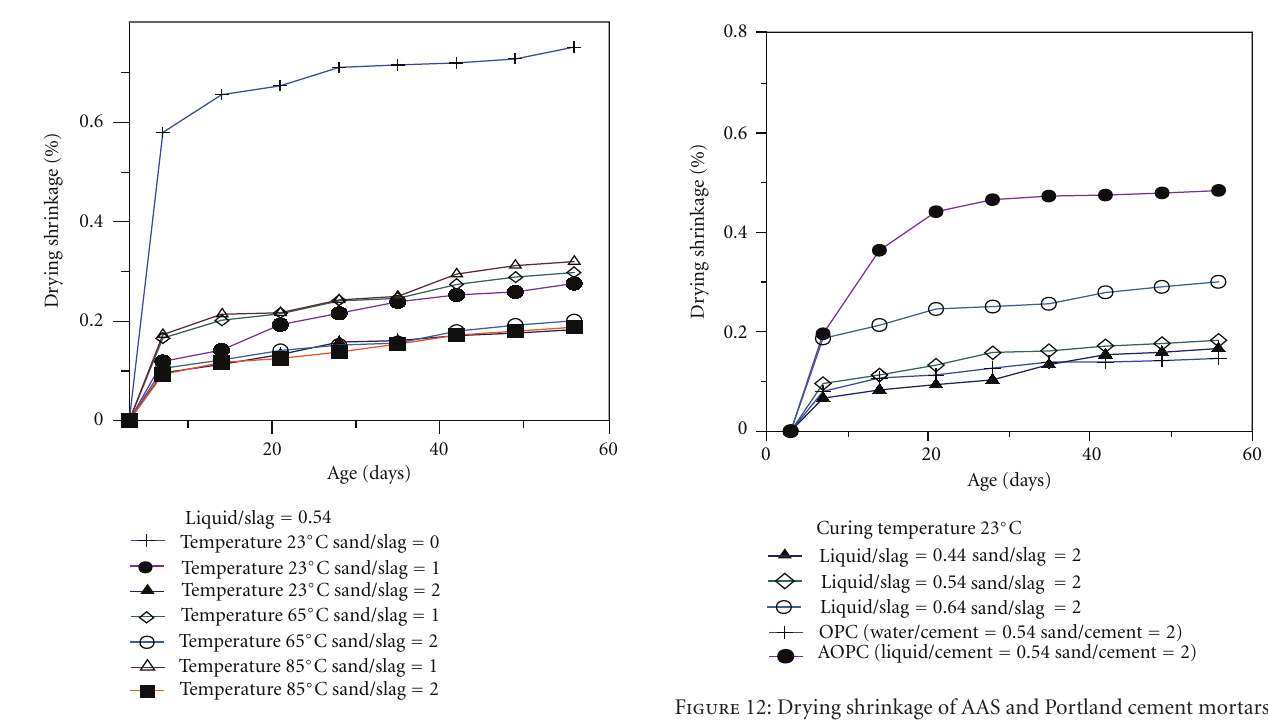
Figure 10: Drying shrinkage of AAS mortars ( L/S = 0 . 54).